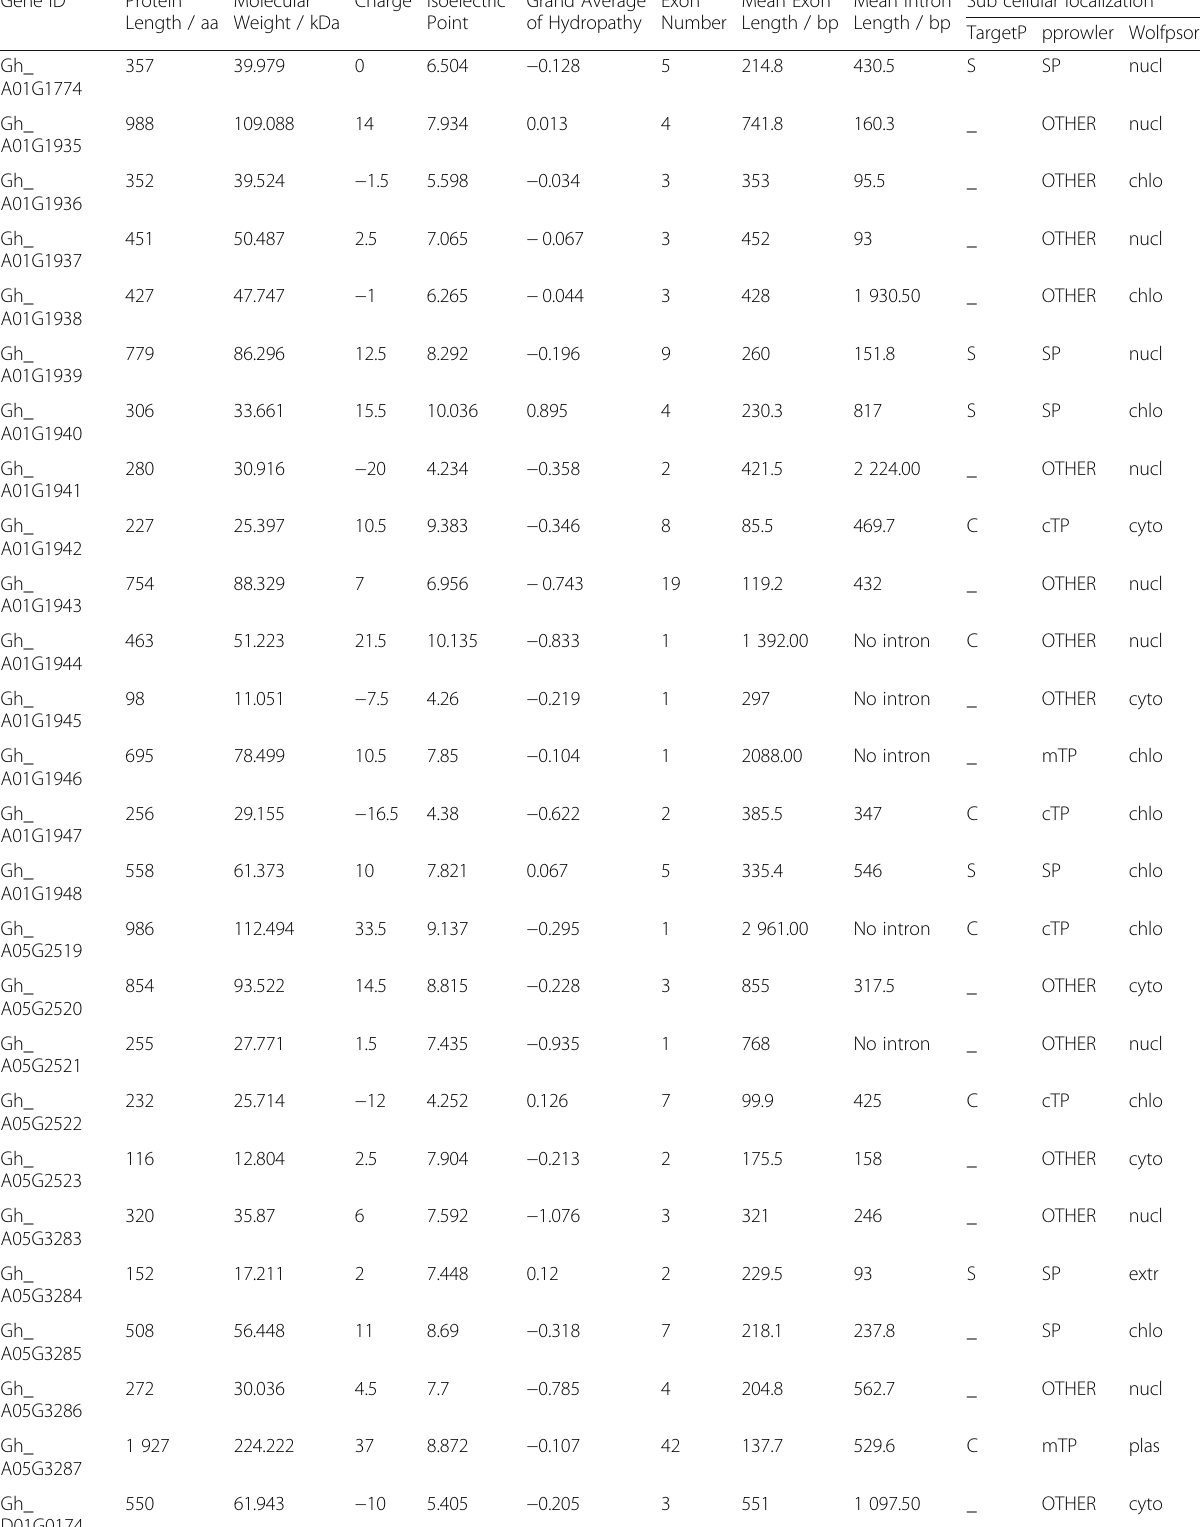
Table 3 Physiochemical properties and sub cellular localization prediction of the mined genes within the major clusters of the consistent QTLs Gene